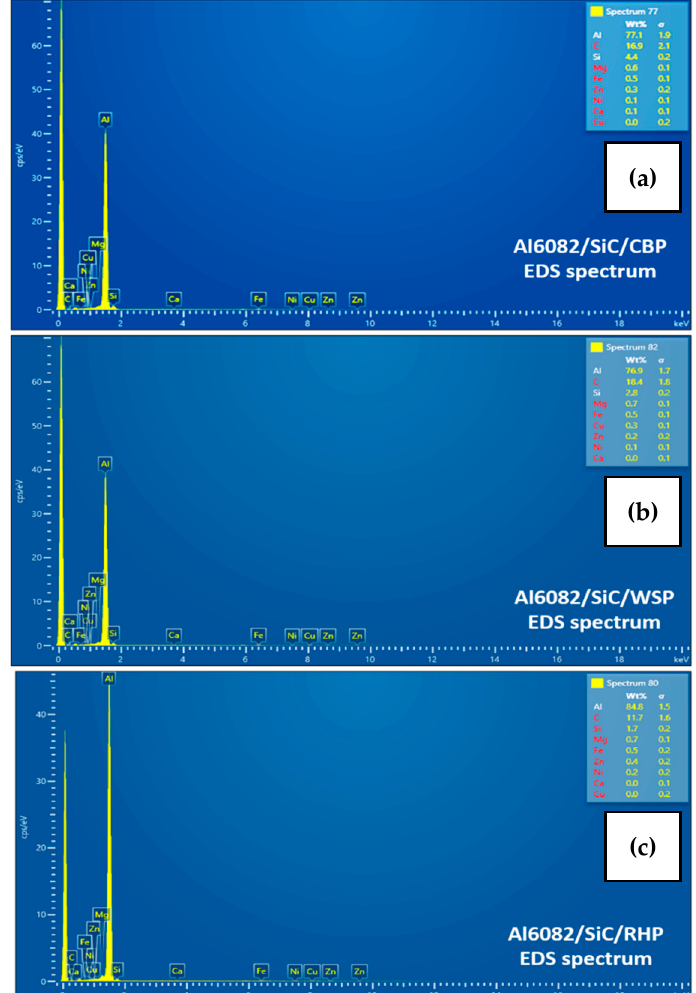
Figure 5. EDS phase mapping; ( a ) Al6082/2% SiC/2%CBP, ( b ) Al6082/2% SiC/2%WSP, ( c ) Al6082/2% SiC/2%RHP.